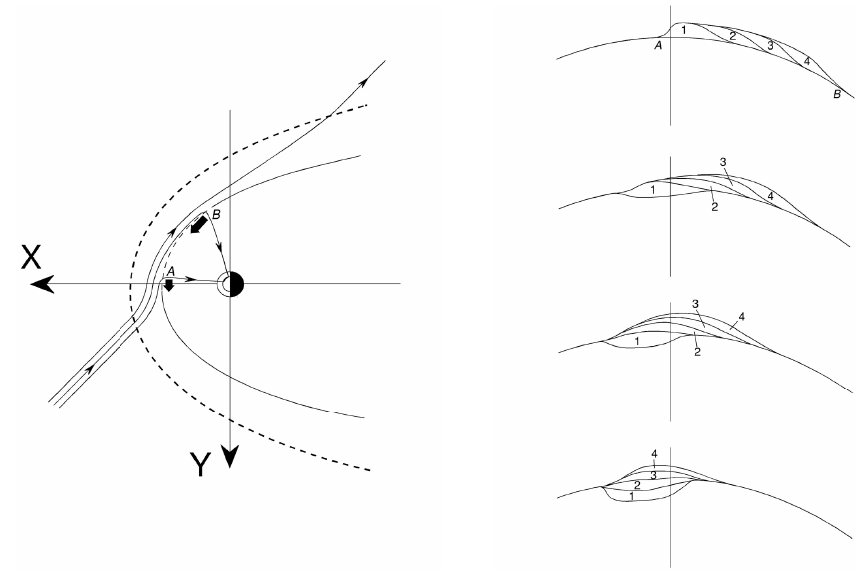
Fig. 23. Left Panel: schematic sketch of the magnetosphere, as viewed from the top. A draped solar wind IMF field line and two newly- reconnected field lines are drawn for a possible reconnection geometry, when the IMF B Y and B X components are both large and negative, while the B Z component is small. Right panel: schematic drawing of the evolution of newly-opened flux, reconnected in successive times, starting at point A (patch 1) and stopping at point B (patch